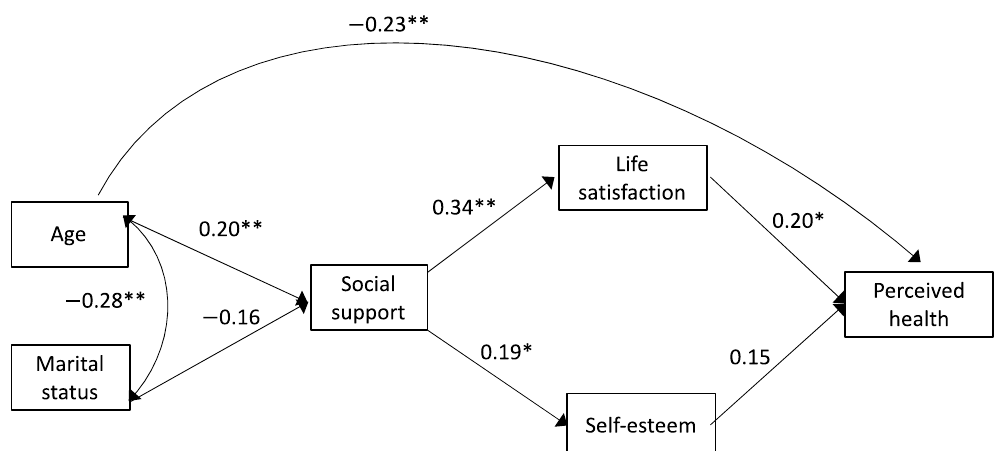
Figure 1. Path analysis to explain perceived general health. Note: Errors are not displayed to improve the visibility of the model. The estimates of the parameters (standardized beta coefficient for regression analyzes, indicated with one-way arrows; and Pearson’s coefficient for correlation, indicated with a two-way arrow) that were statistically significant are indicated: * p ≤ 0.05; ** p ≤